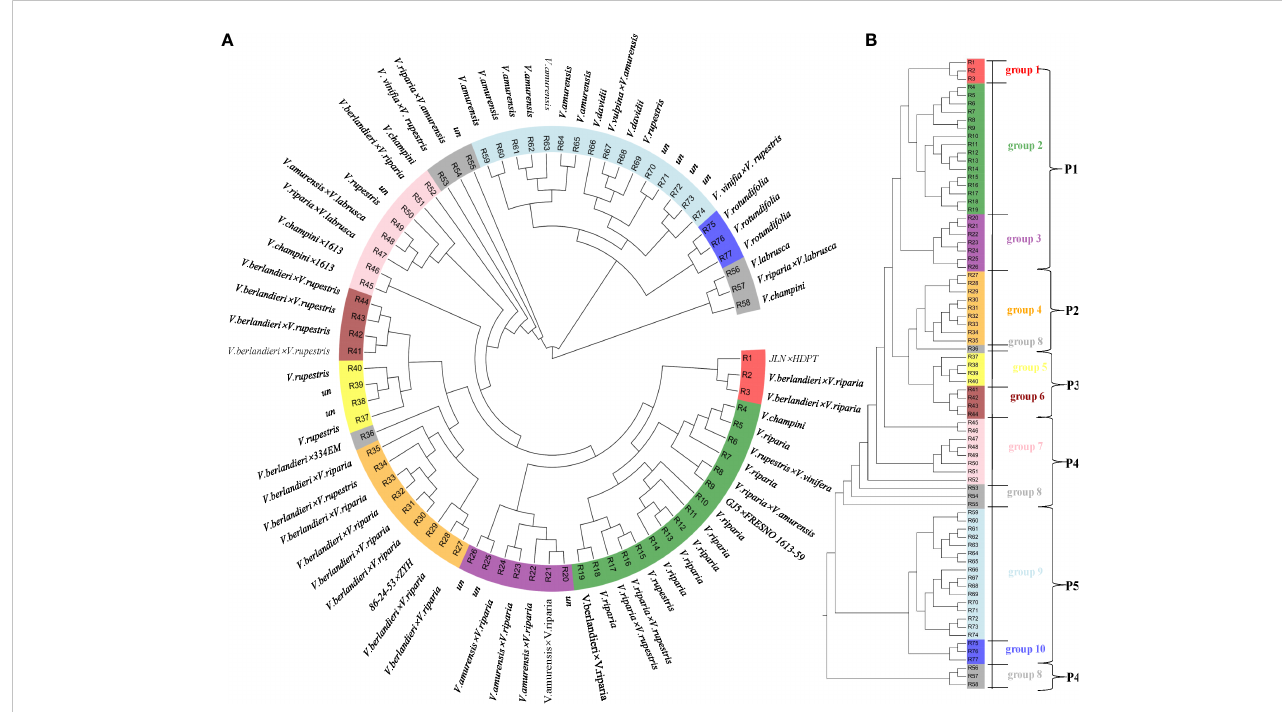
FIGURE 1 Phylogenetic analysis of 77 rootstocks samples. (A) Neighbor-joining (NJ) phylogenetic tree of grapevine accessions inferred from the whole-genome SNPs with 100 nonparametric bootstraps. (B) Five populations of 77 rootstock samples belonging to 10